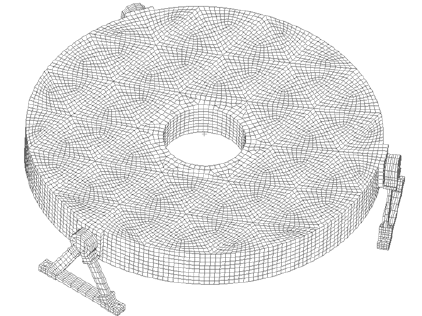
Fig. 12 Finite model of the CFRP mirror. Table 3 FEM analysis results.